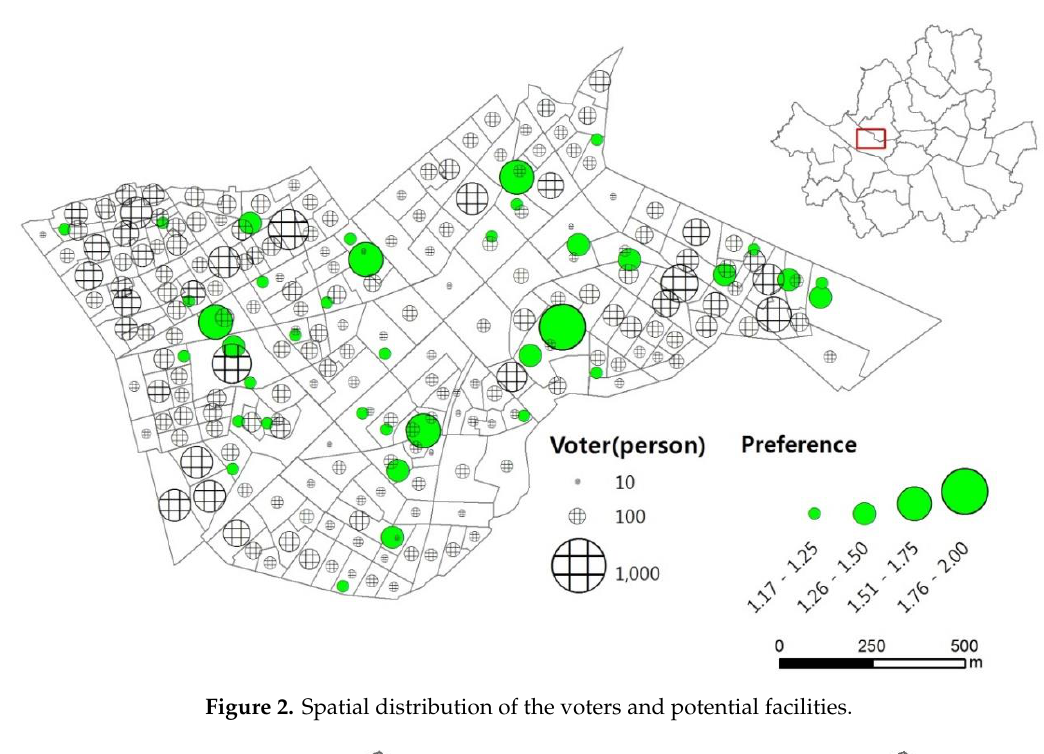
Figure 2. Spatial distribution of the voters and potential facilities.